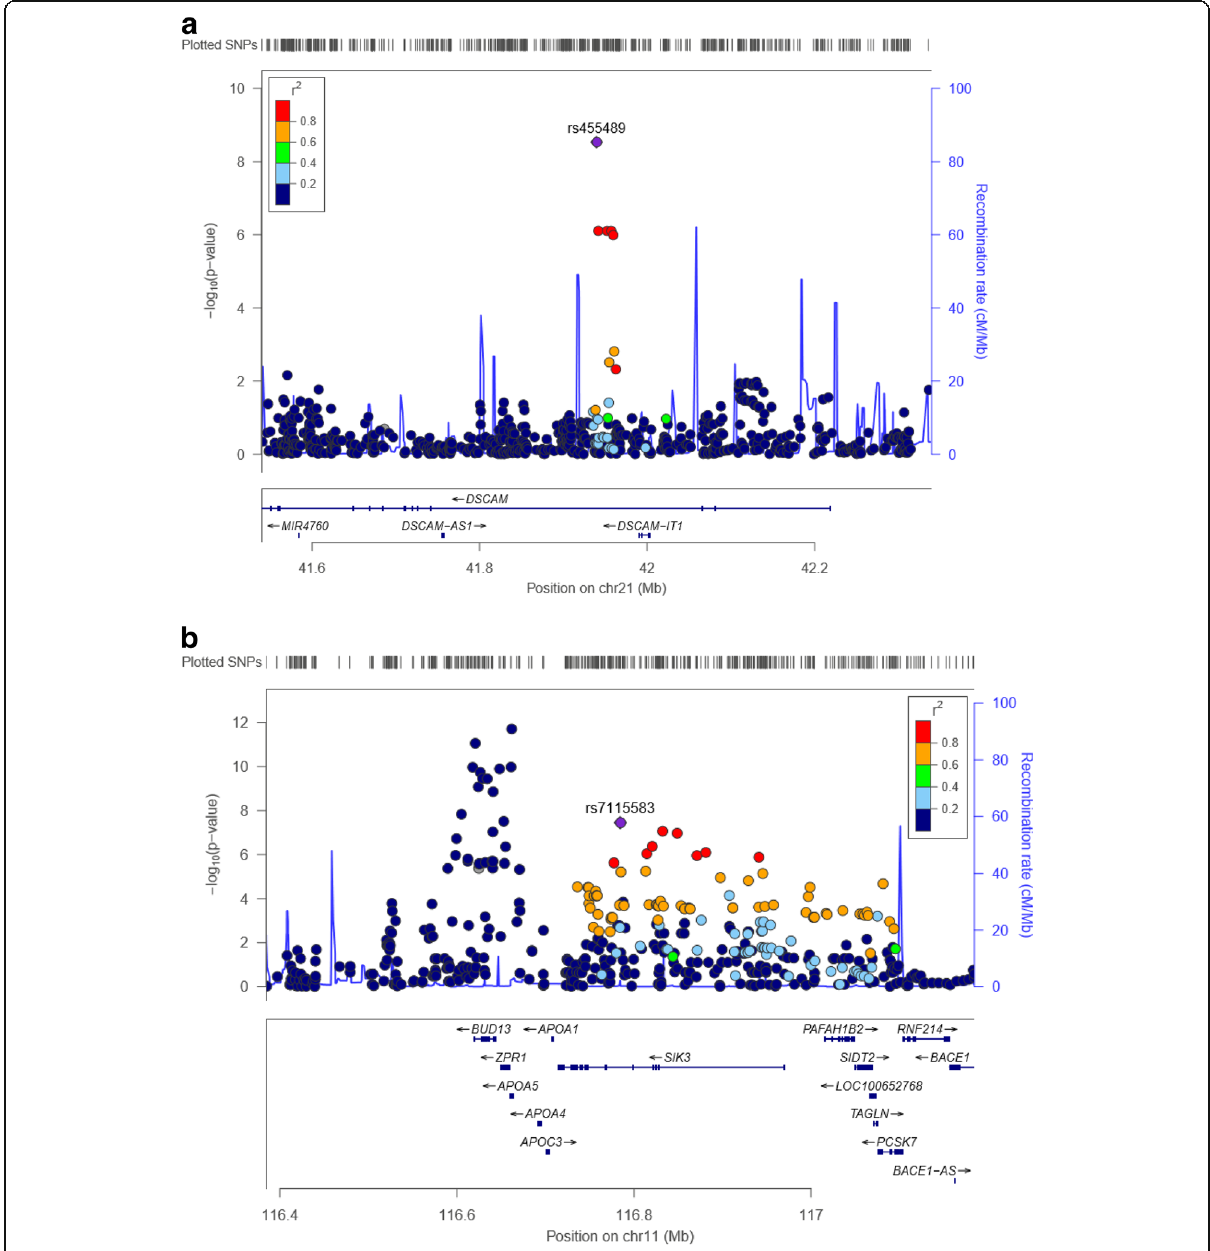
Fig. 2 Regional association plots of newly discovered loci for FPG ( a ) and HDLC ( b ) in females. The SNP positions are shown at the top. The trend test -log 10 P values are shown for SNPs distributed in a 0.8-Mb genomic region centered on the most strongly associated signal, which is depicted as a purple diamond for the combined results from discovery and replication stages. The locations of known genes in the region are shown at the bottom. The genetic information was obtained from the Human Genome build hg 19; the LD structure was based on the 1000 Genomes ASN